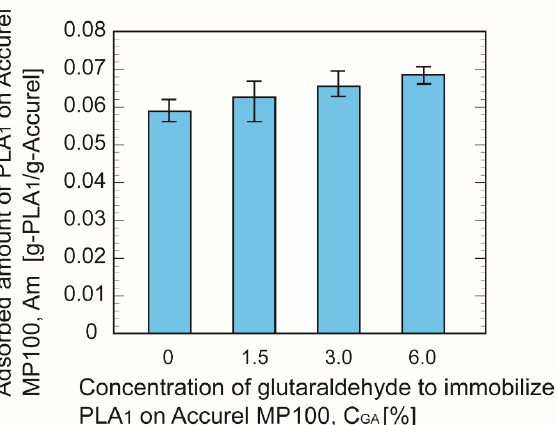
Figure 3. Comparison of the adsorbed amount of phospholipase A 1 per unit mass of Accurel MP100.